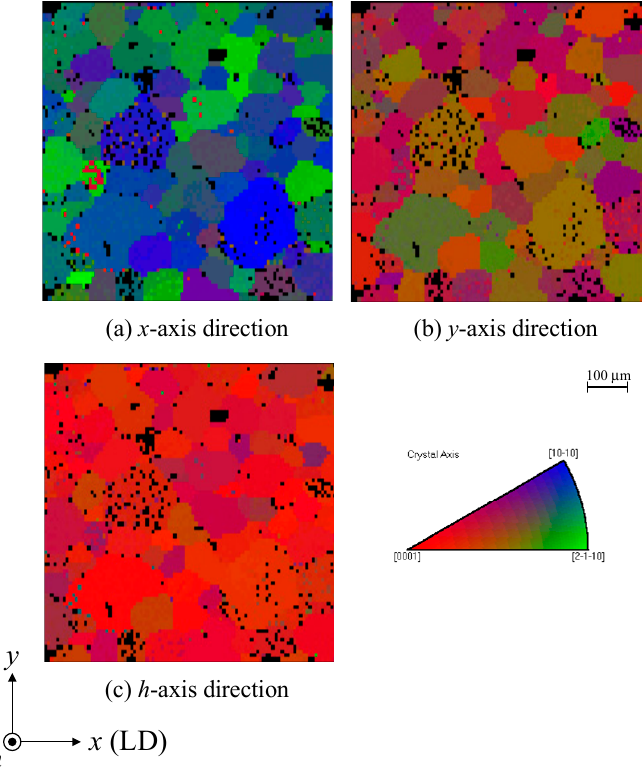
Figure 3. Crystal-orientation map of the specimen.